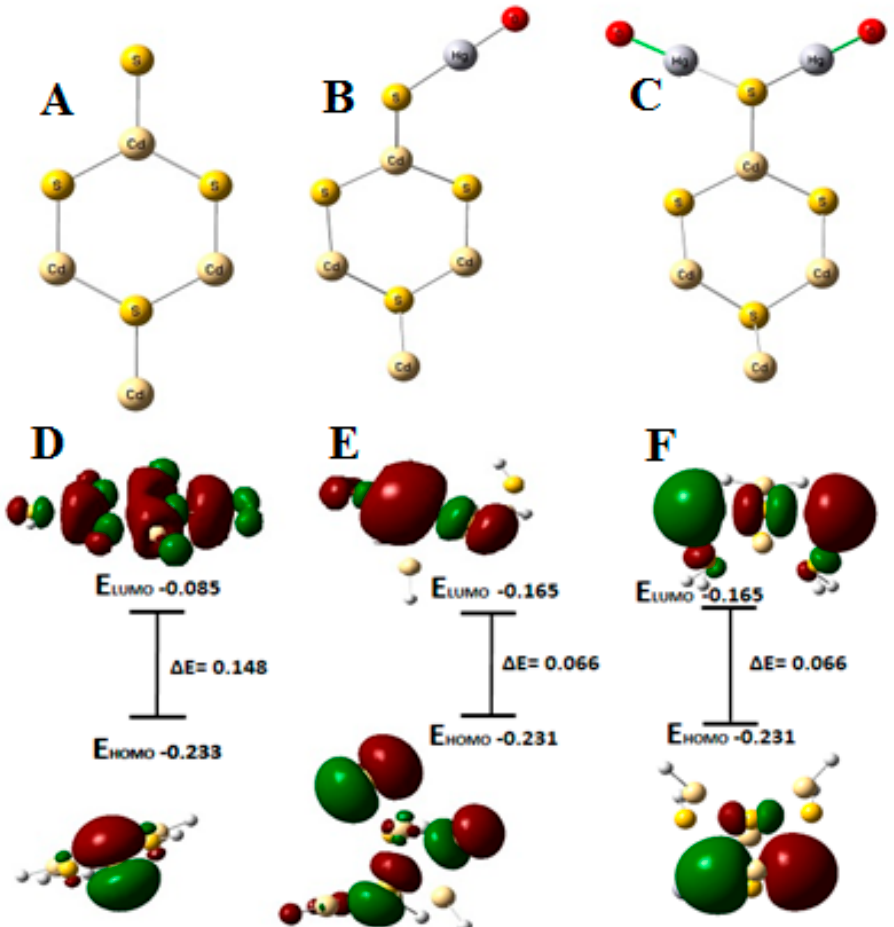
Figure 6. Optimized geometries of ( A ) CdS, ( B ) CdS-Hg, and ( C ) Hg-CdS-Hg binuclear complex; ( C – F ) are energy diagrams and Kohn–Sham frontier molecular orbitals of CdS, CdS-Hg, and Hg-CdS-Hg, respectively.